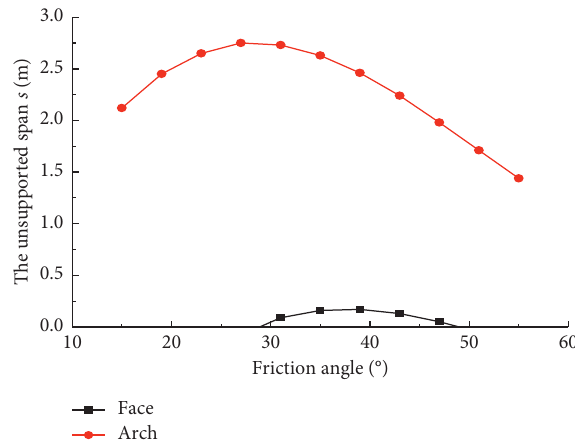
Figure 10: Curves of correlation between the unsupported span and internal friction angle.